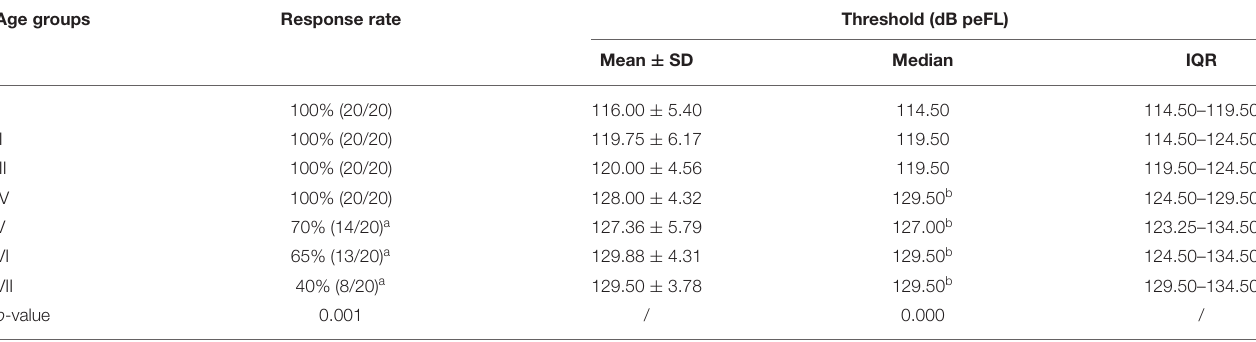
TABLE 4 | The response rate and threshold of B81-oVEMP with increasing age.